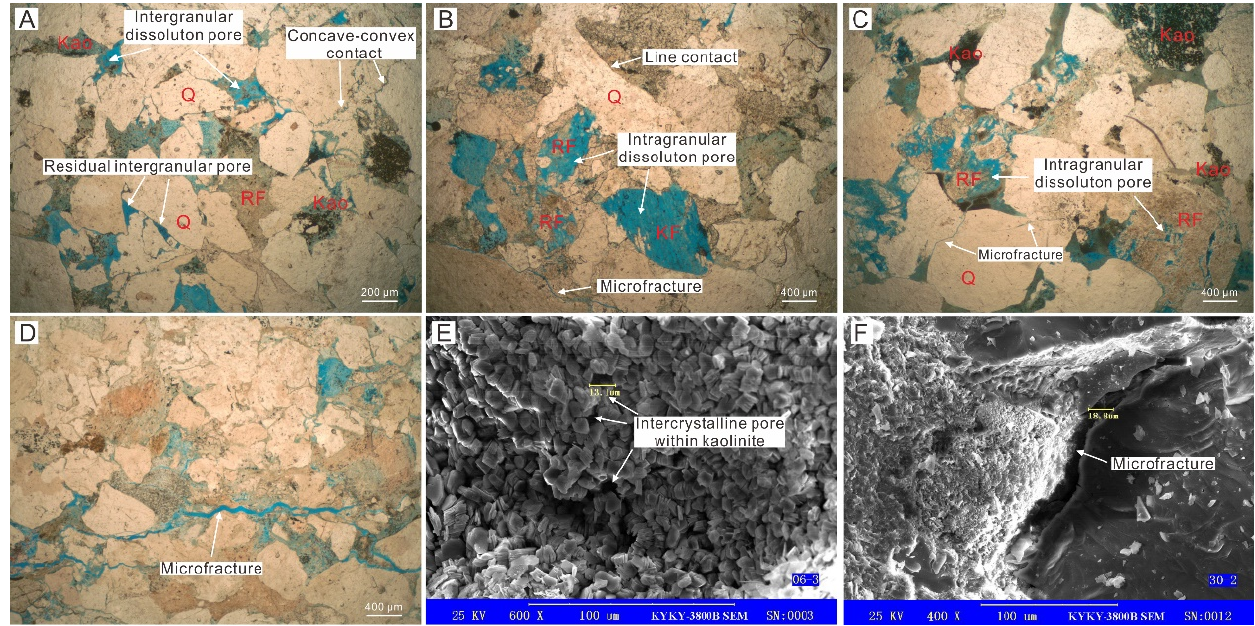
Figure 5. Microscopy and SEM observation showing the types of sandstone reservoir space in the